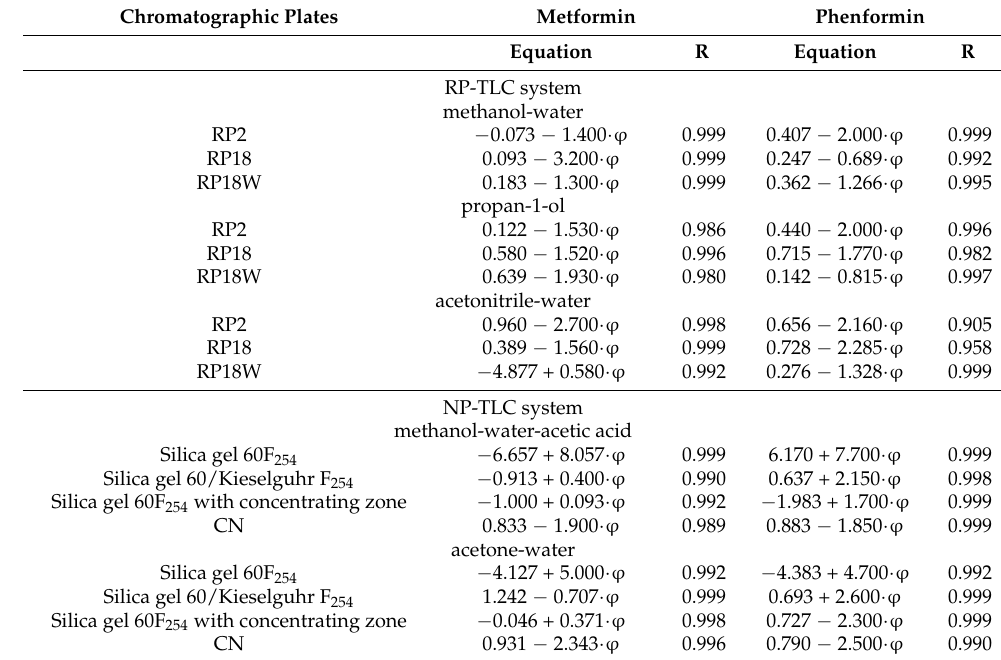
Table 1. The regression parameters (R M ) vs. the organic modifier content in mobile phases R M = R MW − S · ϕ .